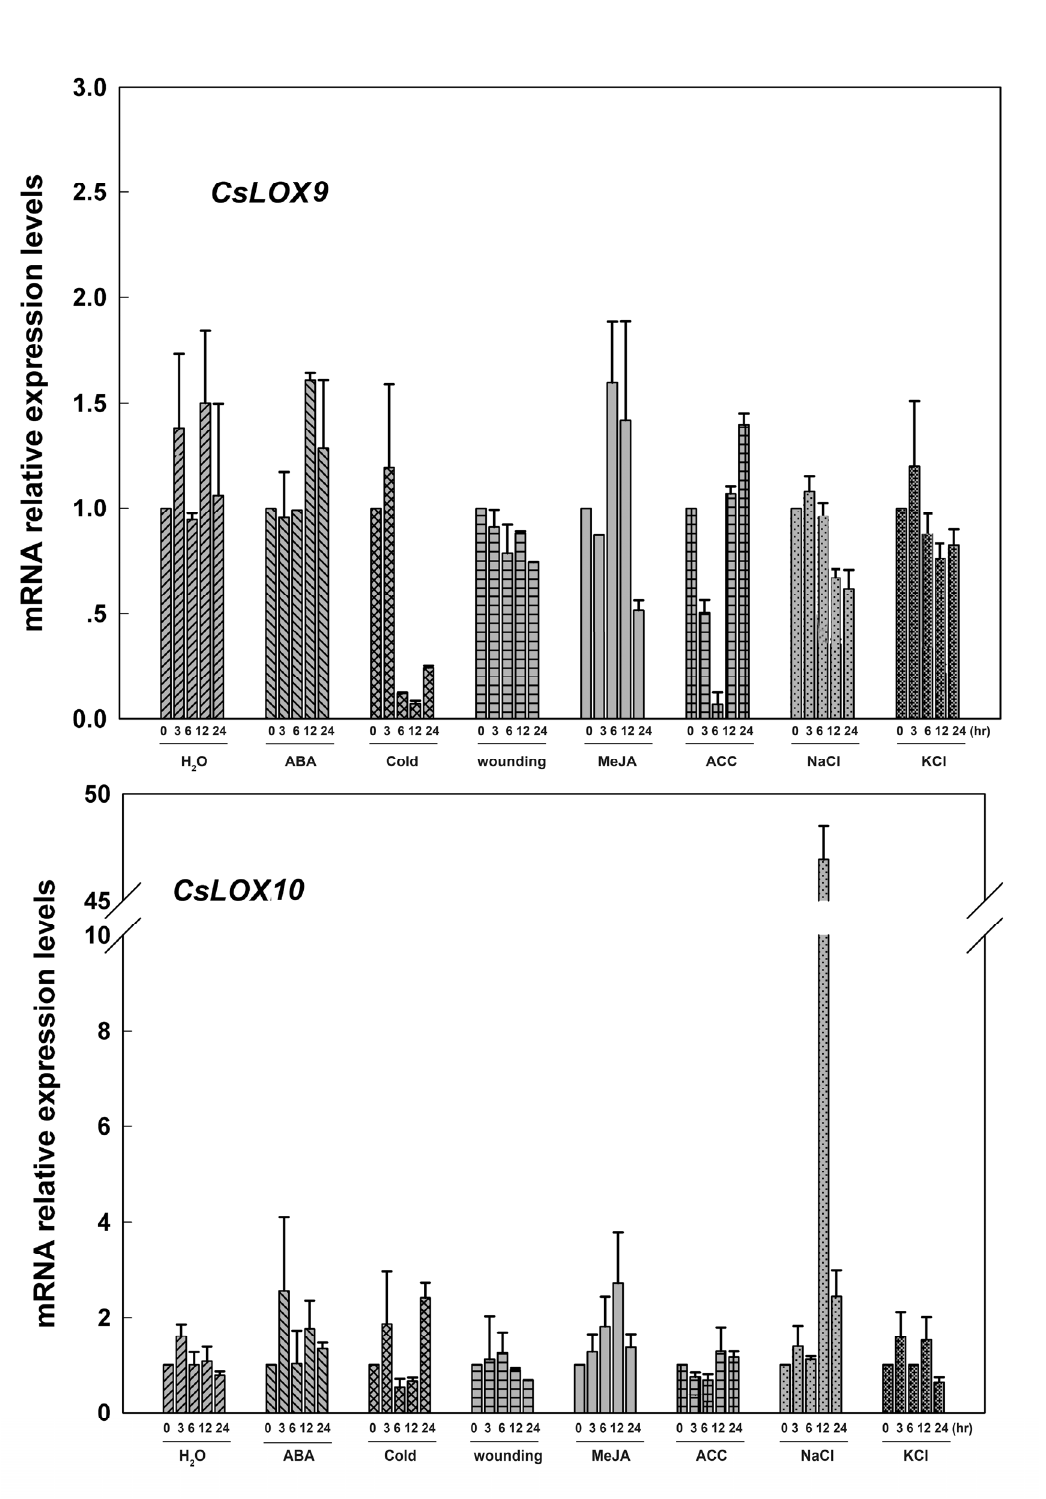
Figure 6. Expressions of CsLOX9 and CsLOX10 in cucumber leaves at various time points under treatments with H O, ABA (100 μ M), cold (4 °C), wounding, MeJA (100 μ M), 2 ACC (100 μ M) NaCl (200 mM) and KCl (200 mM) were analyzed by Real-time PCR. A cucumber actin gene CsACT (Csa017310) was detected as internal reference. Data represent the mean ± SD of three independent biological